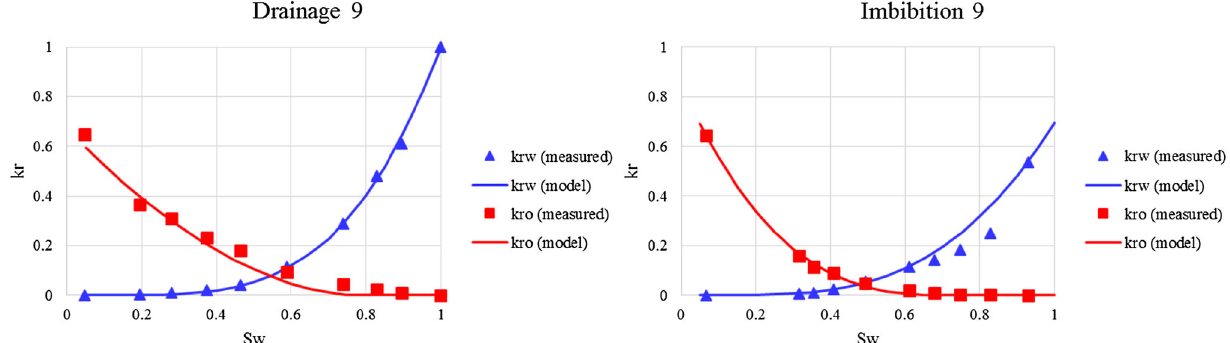
Fig. 12 Drainage and imbibition K r correlation for sample plug